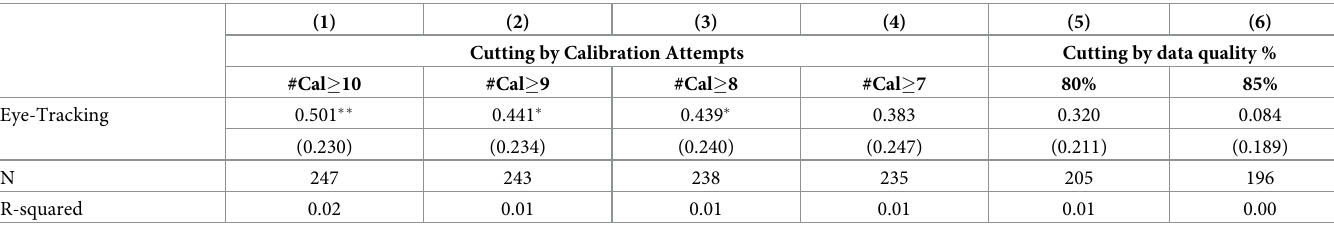
Table 6. Holt and Laury number of safe choices OLS with universe